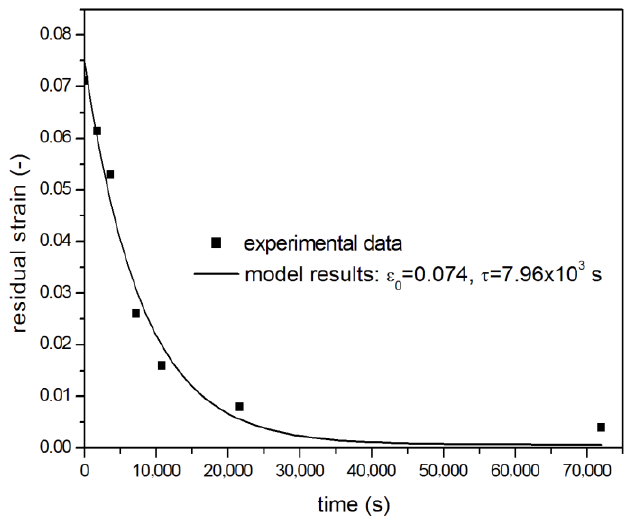
Figure 10. Residual strain of IR heated blank laminates as a function of annealing time at 240 °C, experimental data, and Equation (3) fitting.